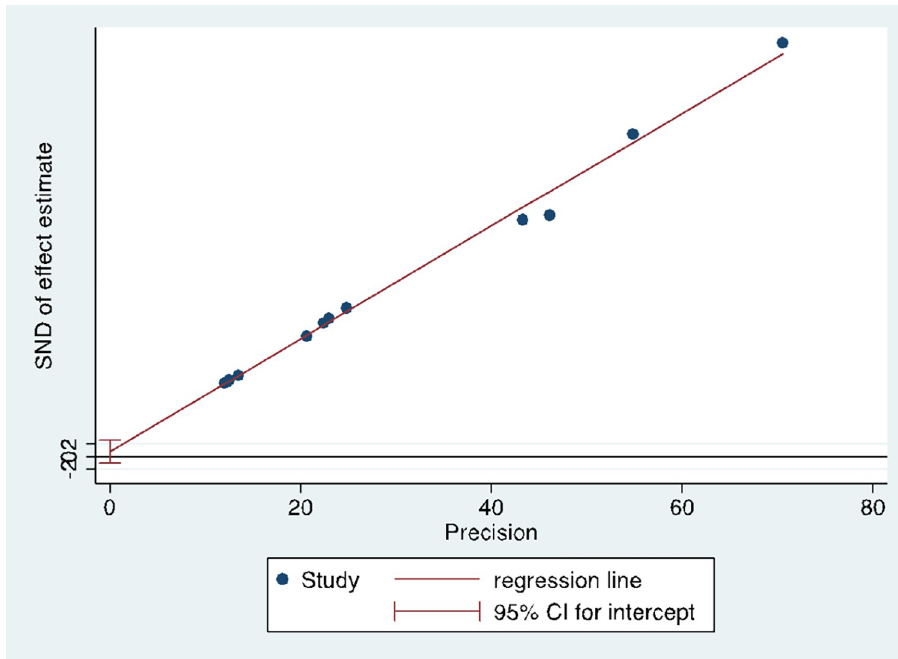
Fig 2. Egger graph to test small study